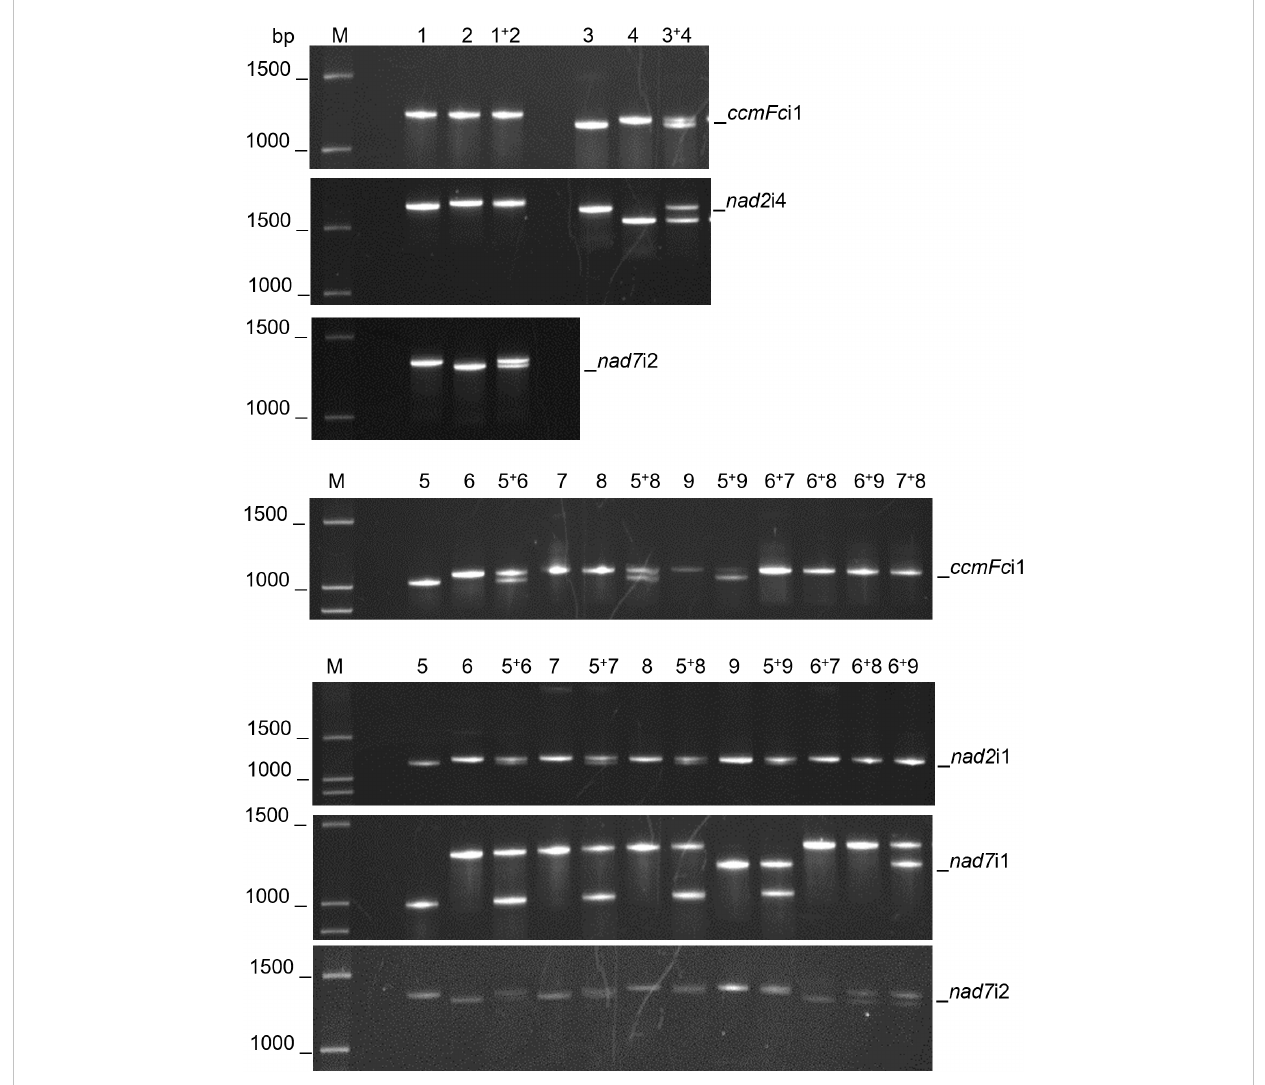
FIGURE 2 Mitochondrial intron length polymorphisms that distinguish related species. PCR ampli fi cation products of mitochondrial introns were separated by polyacrylamide gel electrophoresis. PCR products were analyzed individually and as mixtures to con fi rm the indel polymorphisms. M corresponds to a 100 base pair (bp) DNA ladder. DNA templates for PCR were as follows: 1) Cynodon dactylon Royal Cape, 2) Cynodon transvaalensis Frankenwald Fine, 3) Cenchrus americanus Ti fl eaf3, 4) Cenchrus purpureus Merkeron, 5) Poncirus trifoliata English Large Flower, 6) Citrus japonica Meiwa, 7) Citrus medica Etrog, 8) Citrus maxima Hirado Buntan, 9) Citrus reticulata Ponkan. Polymorphisms between Cenchrus spp. were con fi rmed for ccmFc i1 and nad2 i4 and between Cynodon spp. for nad7 i2. CcmFc i1, nad2 i1, and nad7 i1 polymorphisms differentiated P. trifoliata (5) from Citrus species (7-9). Nad7 i1 also distinguished C. reticulata (9) from C. japonica , C. medica and C. maxima (6-8), whereas nad7 i2 polymorphisms distinguished P. trifoliata , C. maxima and C. reticulata (5, 8, 9) from C. japonica and C. medica (6,